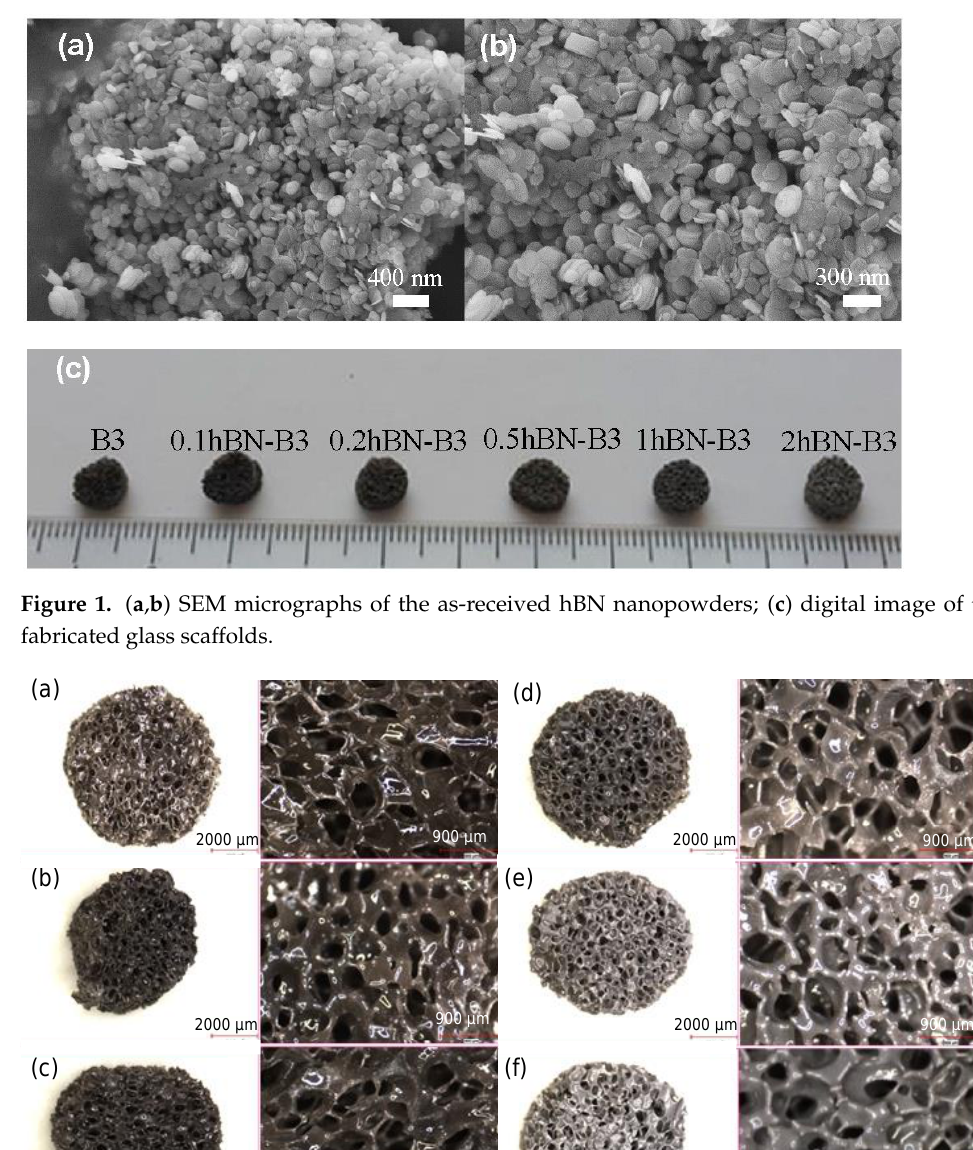
Figure 1. ( a , b ) SEM micrographs of the as-received hBN nanopowders; ( c ) digital image of the fab- ricated glass scaffolds.